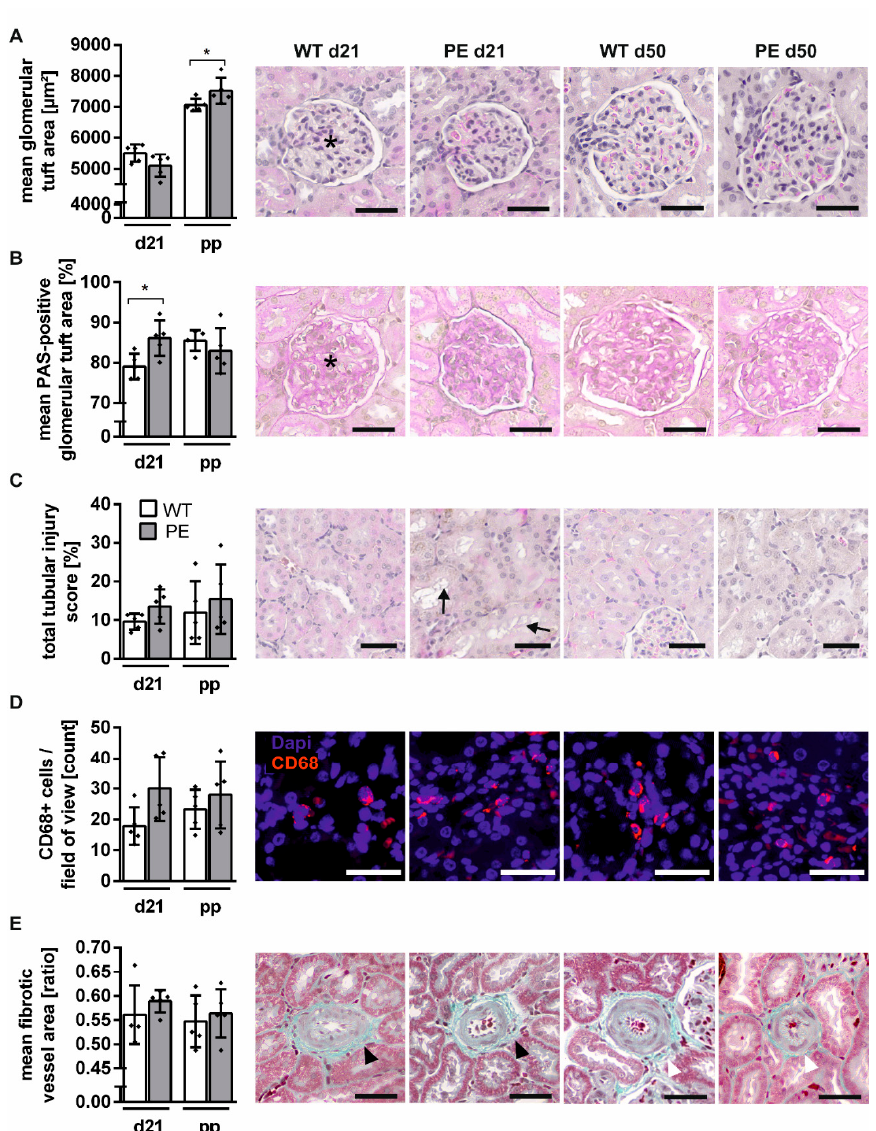
Figure 3. Minimal renal alterations during preeclamptic rat pregnancy. ( A ) Quantification of glomerular tuft area (asterisk) in kidneys of preeclampsia (PE) and control (WT) rats showed no glomerular enlargement during but after preeclamptic pregnancy. Representative images of hemalaun–eosin-stained glomeruli in kidney sections of PE and WT rats are shown. ( B ) The quantification of mean periodic acid–Schiff (PAS)-positive glomerular area displayed a significantly higher density in PE at day 21. Mild glomerular sclerosis was visible in the respective images of PAS-stained glomeruli. ( C ) Semi-quantitative tubular injury analysis revealed no significant difference between groups, though a slight tendency to increased damage was visible in PE at day 21. Total tubular injury score was gathered in a blinded manner in percent. Exemplary images of hemalaun–eosin-stained proximal tubules displayed mild tubular dilation and brush border thinning (arrows) at PE day 21. ( D ) Inflammation was not significantly higher in preeclamptic kidney tissue. CD68-positive cells were counted in ten fields of view per kidney. Representative images of immunohistochemically stained kidney sections for WT and PE were counterstained with DAPI (blue). Primary mouse anti-rat CD68 antibody (clone ED1) and secondary Cy3-conjugated anti-mouse antibody (red) were used. ( E ) PE did not cause perivascular fibrosis in kidney tissue. Relative fibrotic vessel area (arrow head) did not show differences between preeclamptic (PE) and control (WT) rats at all time points. Example images of Masson–Goldner trichrome-stained kidney sections displayed similar-sized connective tissue areas of the arteries. Bars are shown as mean ± SD ( n = 5), analyzed with a two-way ANOVA. p -values are indicated as * p ≤ 0.05 (between groups). Respective images are presented with scale bars (40 µ